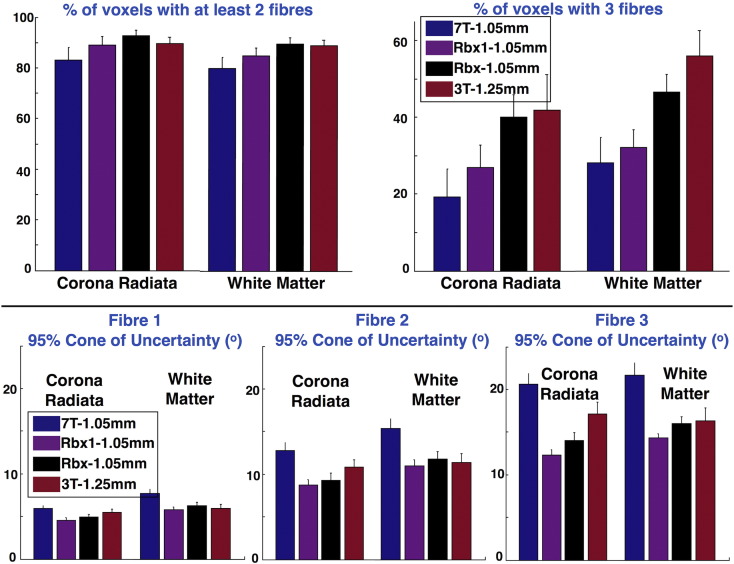
Number of crossing fibres (top row) and uncertainty of estimated orientations (bottom row) obtained using four different methods: voxel-wise deconvolution at 3T (red), voxel-wise deconvolution at 7T (blue), RubiX deconvolution using both 3T and 7T and w = 1 for model selection (Rbx1, purple) and RubiX deconvolution using w = 0.8 (Rbx, black). Notice the difference in the spatial resolution, on which each method operates and estimates fibre orientations. Two ROIs have been considered, one in the corona radiata (obtained from the Johns Hopkins University white matter atlas (Wakana et al., 2007)) and one covering the white matter. The bars correspond to the mean and standard deviation across 10 subjects. For each subject and each ROI, the mean values were obtained. Only fibre orientations with f > 5% were considered. The percentages at the top row are expressed as fractions of the total ROI volume. The uncertainties at the bottom correspond to the 95% cone of uncertainty (Jones, 2003).